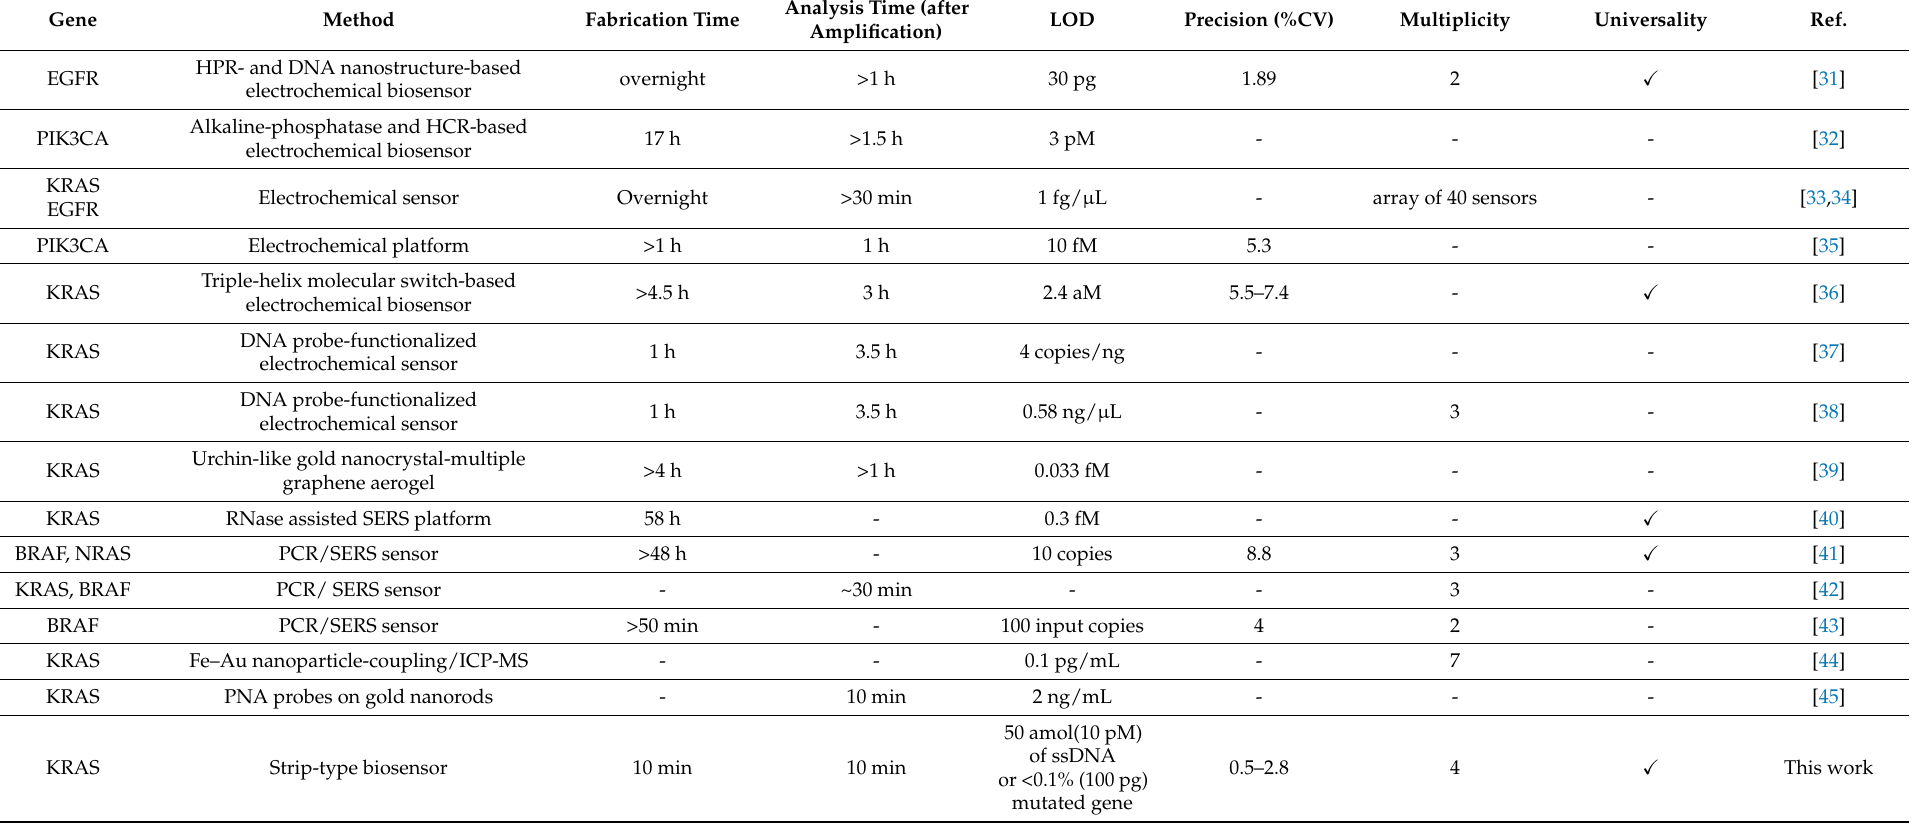
Table 2. Comparison of biosensors for gene mutations detection in ctDNA in real